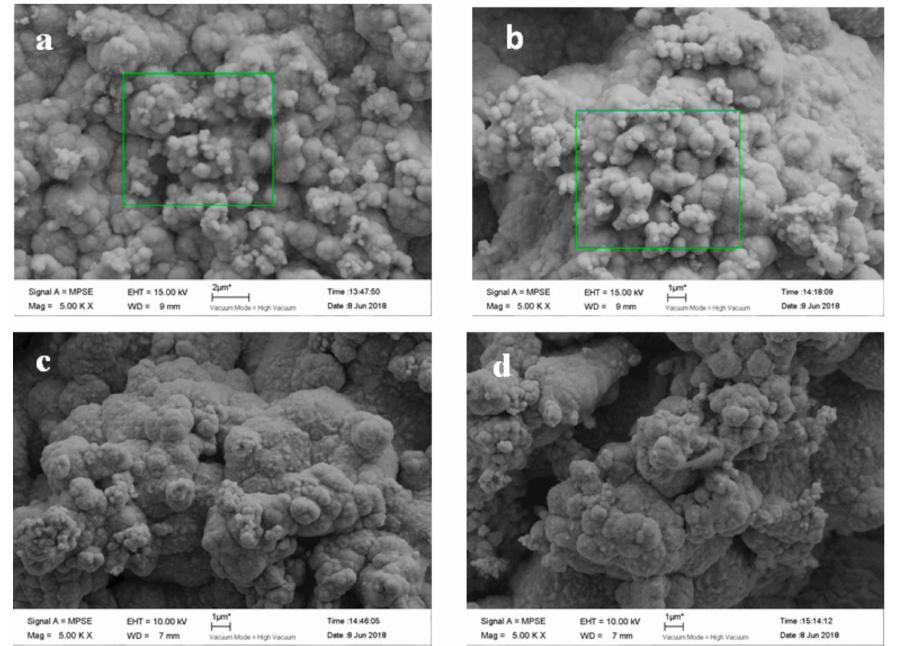
Figure 14. SEM images of composite coating obtained by electroplating at di ff erent stirring speeds: ( a ) 10 r / min, ( b ) 7.5 r / min, ( c ) 5 r / min, and ( d ) 2.5 r / min.